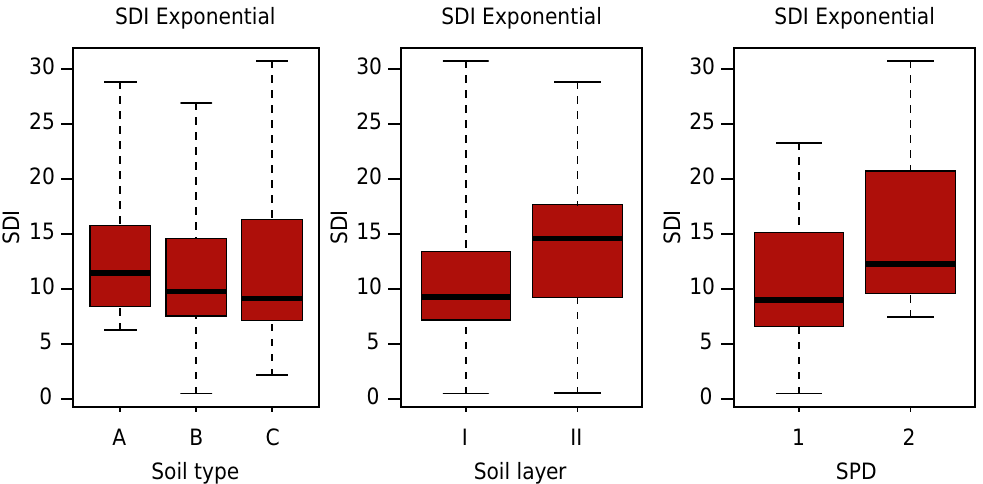
Figure 3. Boxplot graphs of the distribution of the SDI for the exponential model in different soil types, soil layers, and spatial dependencies, obtained from real data. Soil type: A = Ultisol (n = 44), B = Oxisol (n = 47), C = Others (n = 21). Soil layer: I = Surface layer (0.0-0.1, 0.0-0.2 m) (n = 71), II = Bottom layer (0.1-0.2, 0.15-0.30, 0.2-0.3, 0.2-0.4, 0.4-0.5, 0.4-0.6 m) (n = 34). SPD: 1 = 25 ≤ SPD ≤ 75 % (n = 72), 2 = SPD > 75 % (n = 40).